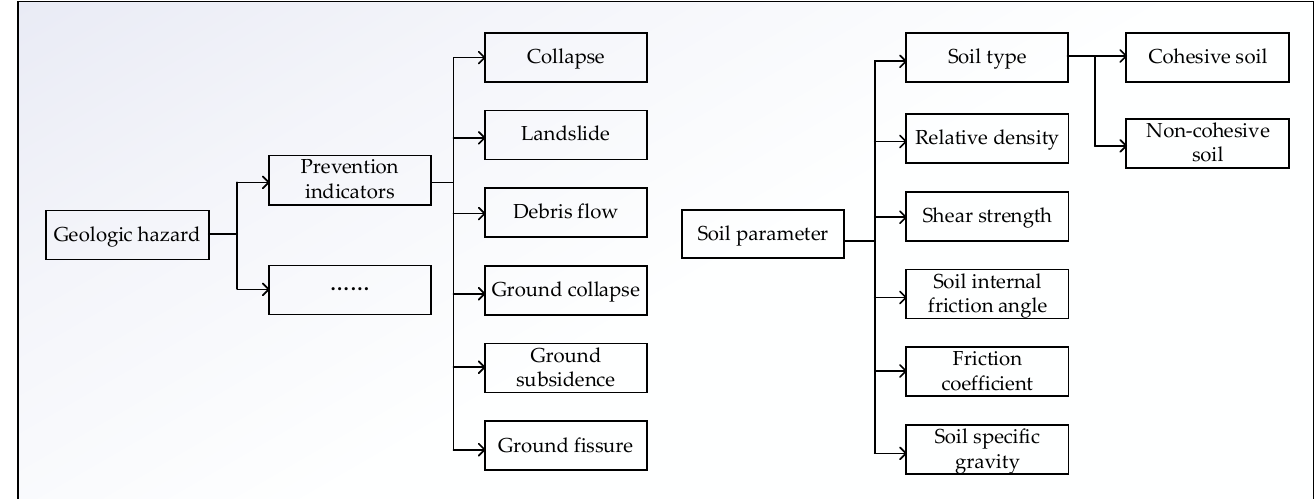
Figure 4. Schematic diagram of the knowledge structure generated by the sample